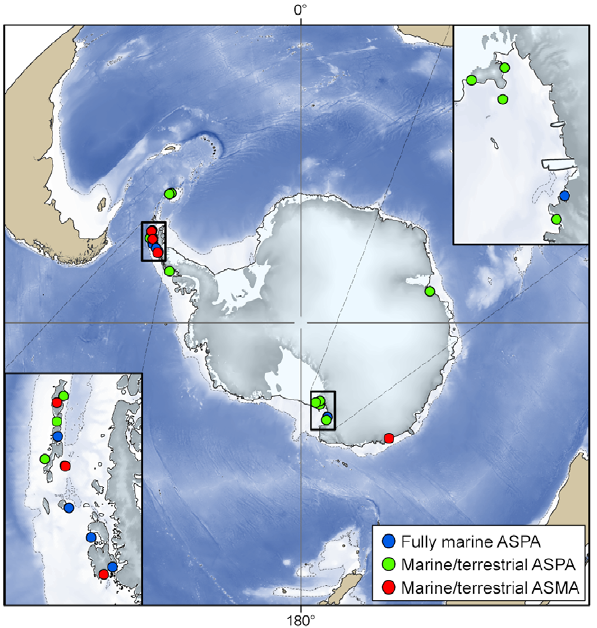
Figure 9. Marine conservation areas in the Antarctic. The locations of the marine and partly marine Antarctic Specially Protected Areas (ASPAs) and Antarctic Specially Managed Areas (ASMAs). (Courtesy of Susie Grant of the British Antarctic Survey, using data extracted from the Antarctic Treaty Secretariat Protected Areas